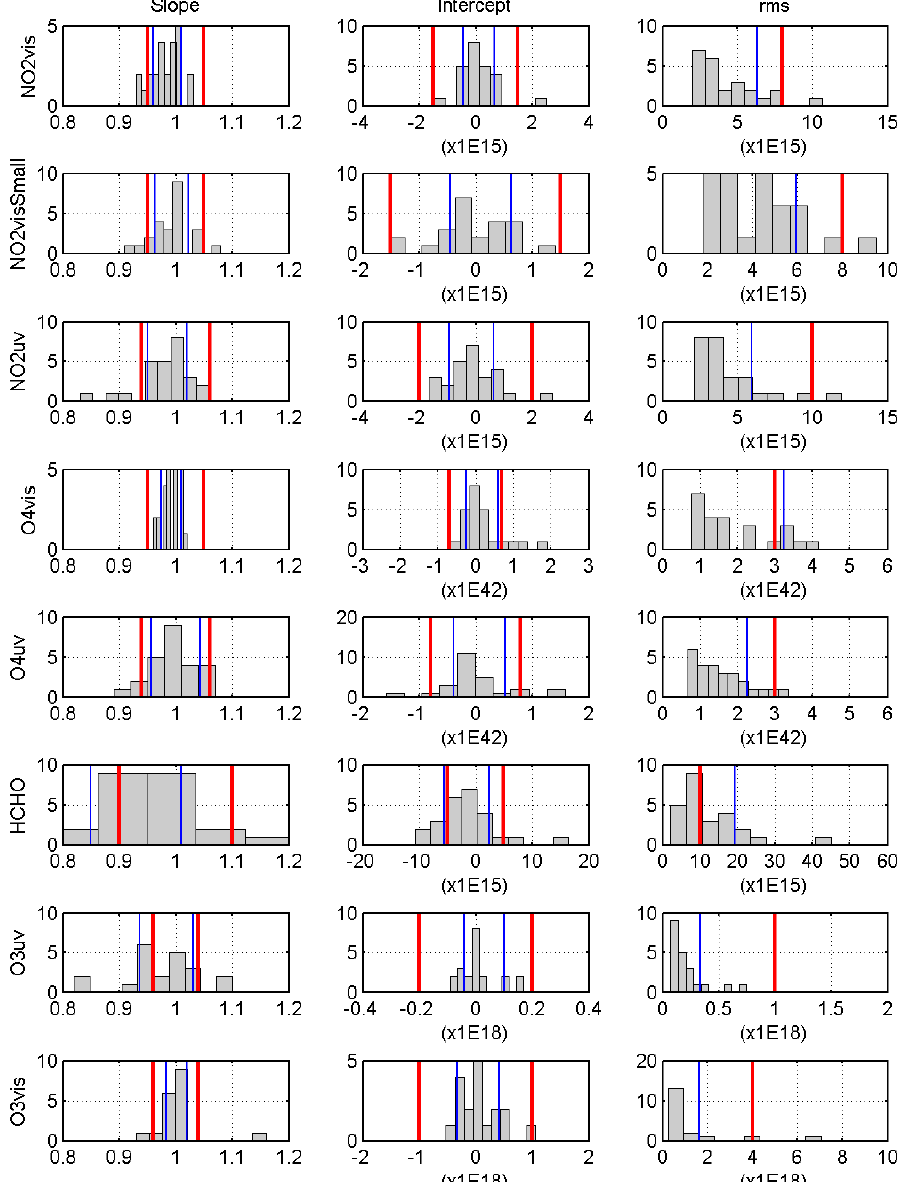
Figure 18. Limits for the assessment criteria for the eight MAX-DOAS data sets shown by red lines. The blue lines represent the percentiles 16 and 84 (84 only for rms), together with histograms of the slope being displayed in the left column of panels, the intercept in the middle and the rms in the rightmost panels (see also Table